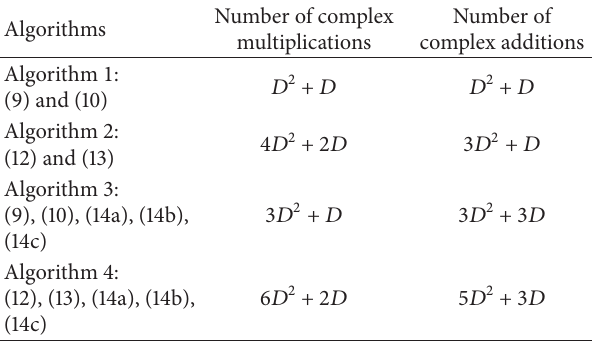
Table 1: Comparison of computational complexity.